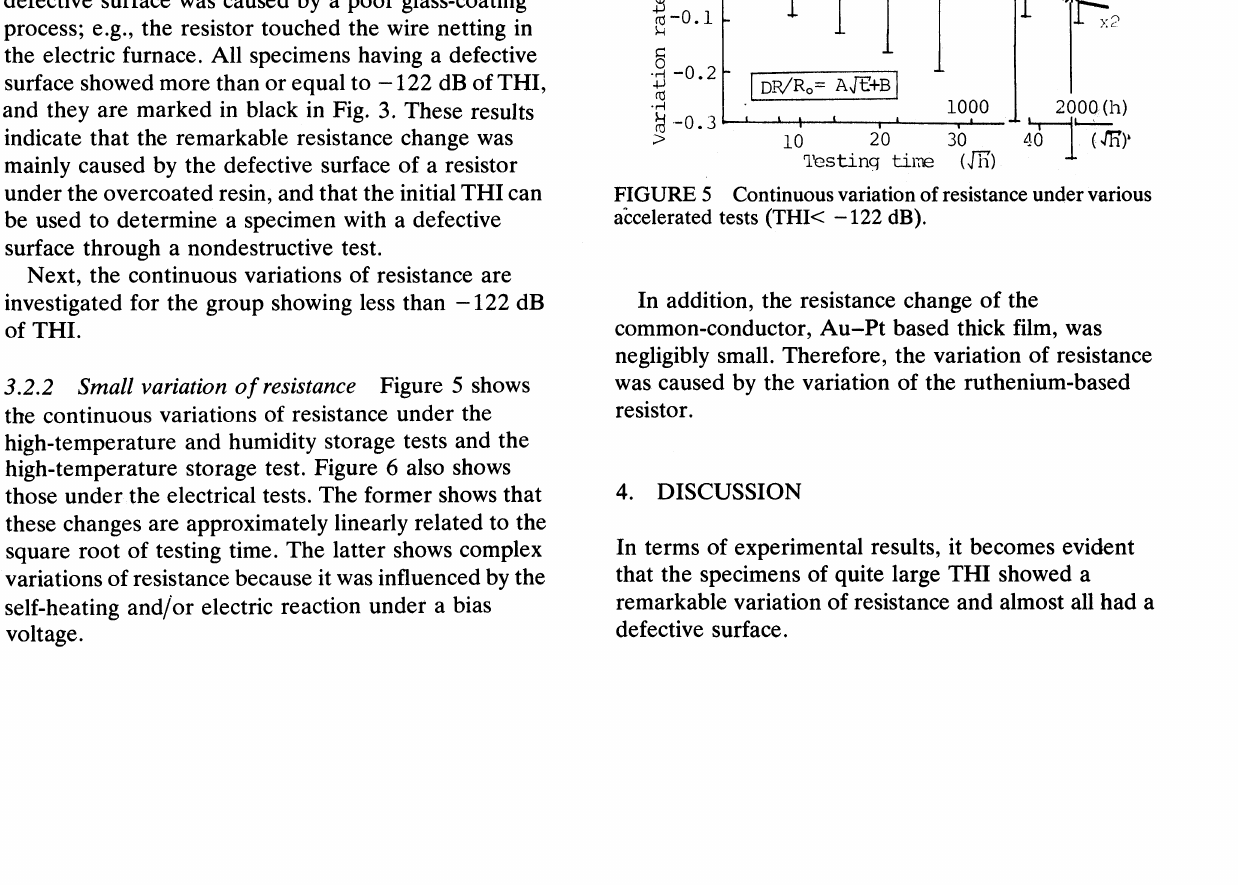
FIGURE 5 Continuous variation of resistance under various acelerated tests (THI< -122